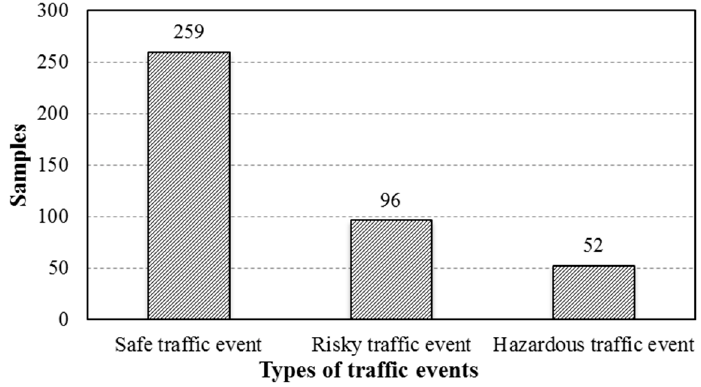
Figure 7. The number of different types of traffic events.